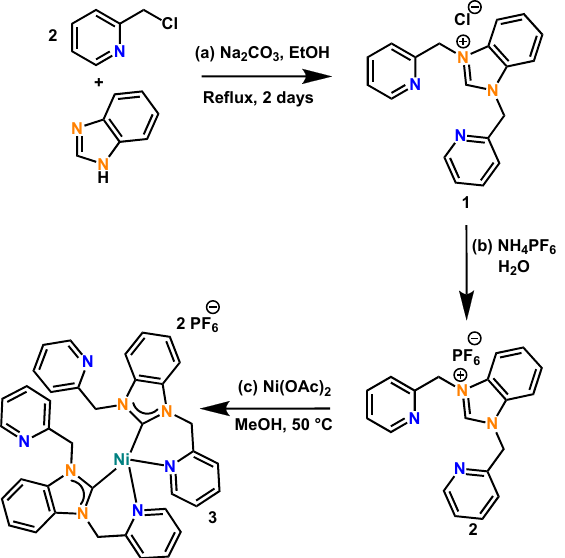
Scheme 1. Reaction scheme for (a) ligand generation, (b) ion metathesis to PF 6 − salt, and (c) carbene generation and metal ion ligation in the formation of the nickel(II)-NHC complex ( 3 ).